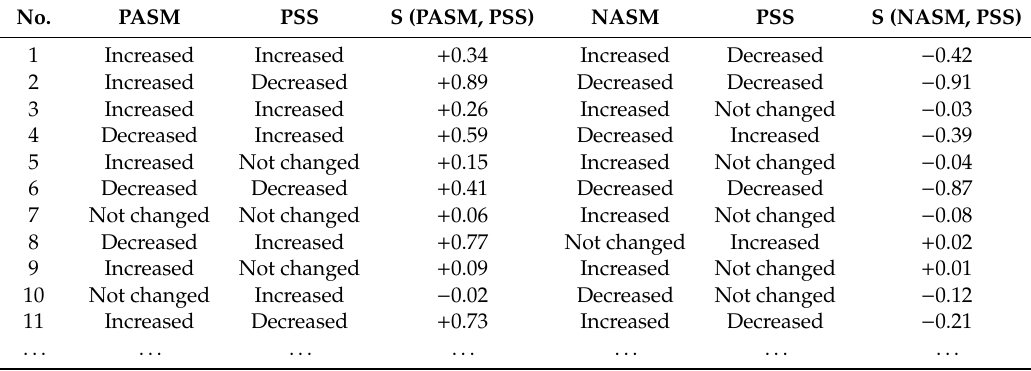
Table 2. Correlation coefficient of S (PASM, PSS), S (NASM, PSS).